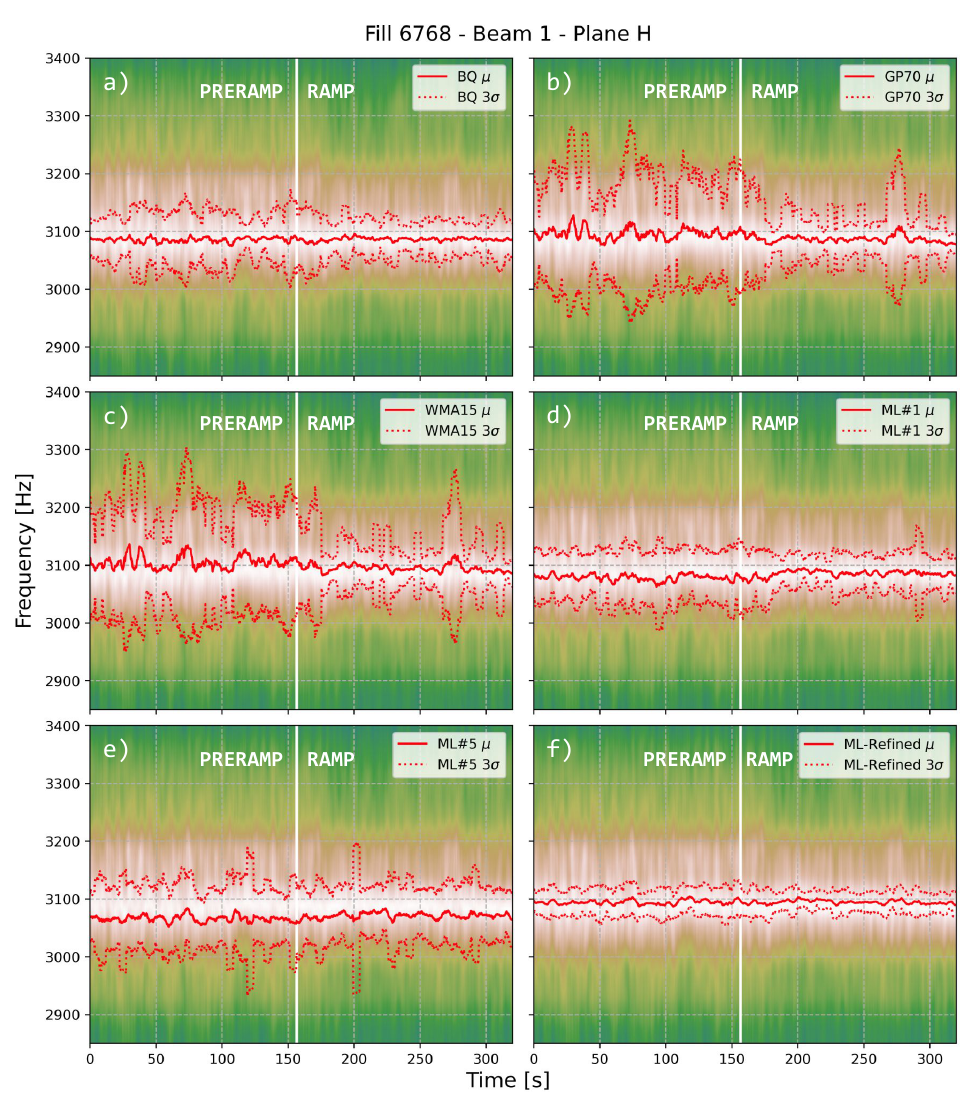
Figure 14. (Background) Heat map obtained by post-processing BBQ spectra from LHC Fill 6768, Beam 1, Horizontal plane, in the transition from PRERAMP to RAMP. (Foreground) Superimposed is the mean, µ , and scaled standard deviation, 3 σ , of the tune evolution as estimated by different tune estimation algorithms and ML models. ( a ) The original algorithm used in the LHC until Run 2 (BQ) ( b ) Tune estimation using Gaussian Processes with an RBF kernel having a length scale of 70 (GP70) [7] ( c ) Tune estimation using a Weighted Moving Average with a window half length of 15 (WMA15) [7] ( d ) The best DNN model trained using simulated spectra (ML#1) ( e ) The best 1D CNN model trained using simulated spectra (ML#5) ( f ) DNN model with the same architecture as ML#1 and trained using spectra refined by